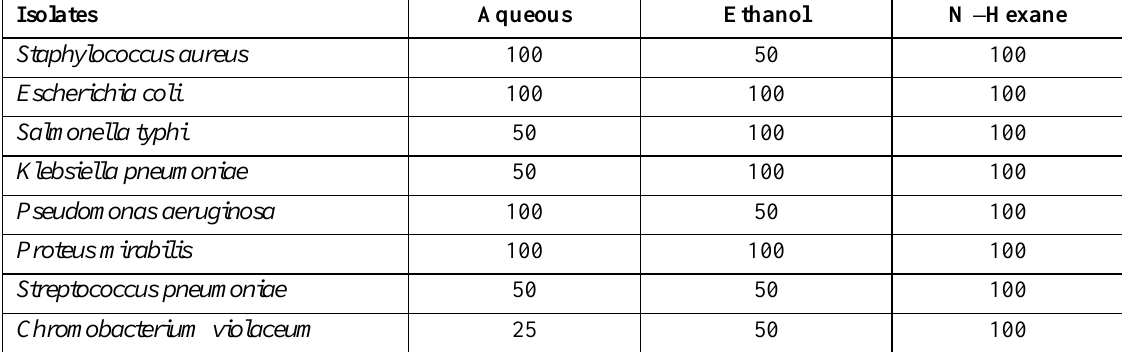
Table 6. Minimum bactericidal concentration (MBC) (mg/ml), of leaf extracts of Citrus aurantium on Bacterial Isolated from hepatitis B surface antigen positive